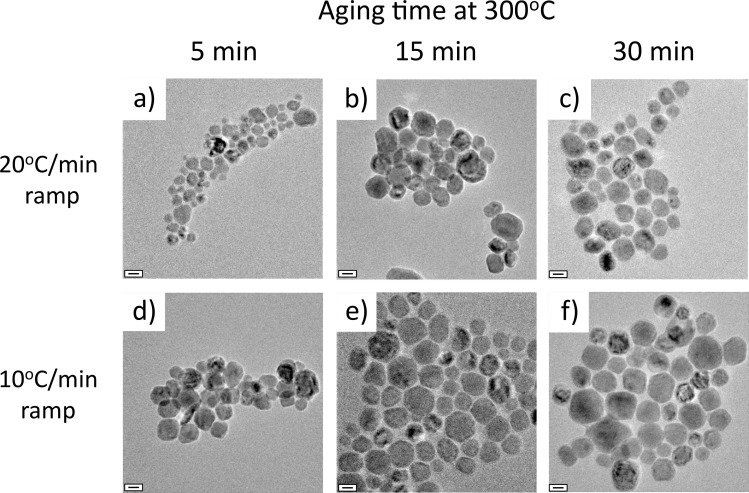
TEM images of MnO NPs generated from each of the 6 different temperature profiles: 20°C/min ramp with a) 5 min at 300°C, b) 15 min at 300°C, c) 30 min at 300°C, and 10°C/min ramp with d) 5 min at 300°C, e) 15 min at 300°C, and f) 30 min at 300°C. The MnO NPs have a rounded octagon shape, but some variation in size. Scale bars are 20 nm.